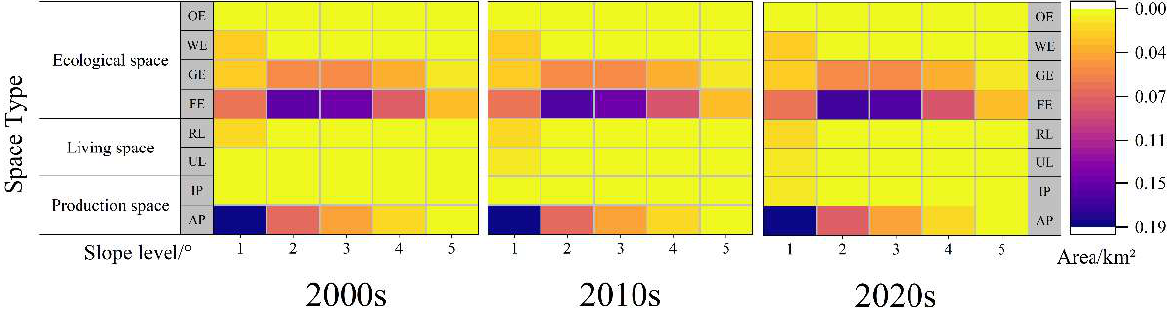
Figure 6. Slope terrain distribution index of the territorial space of the Yangtze River Economic Belt from 2000 to 2020.